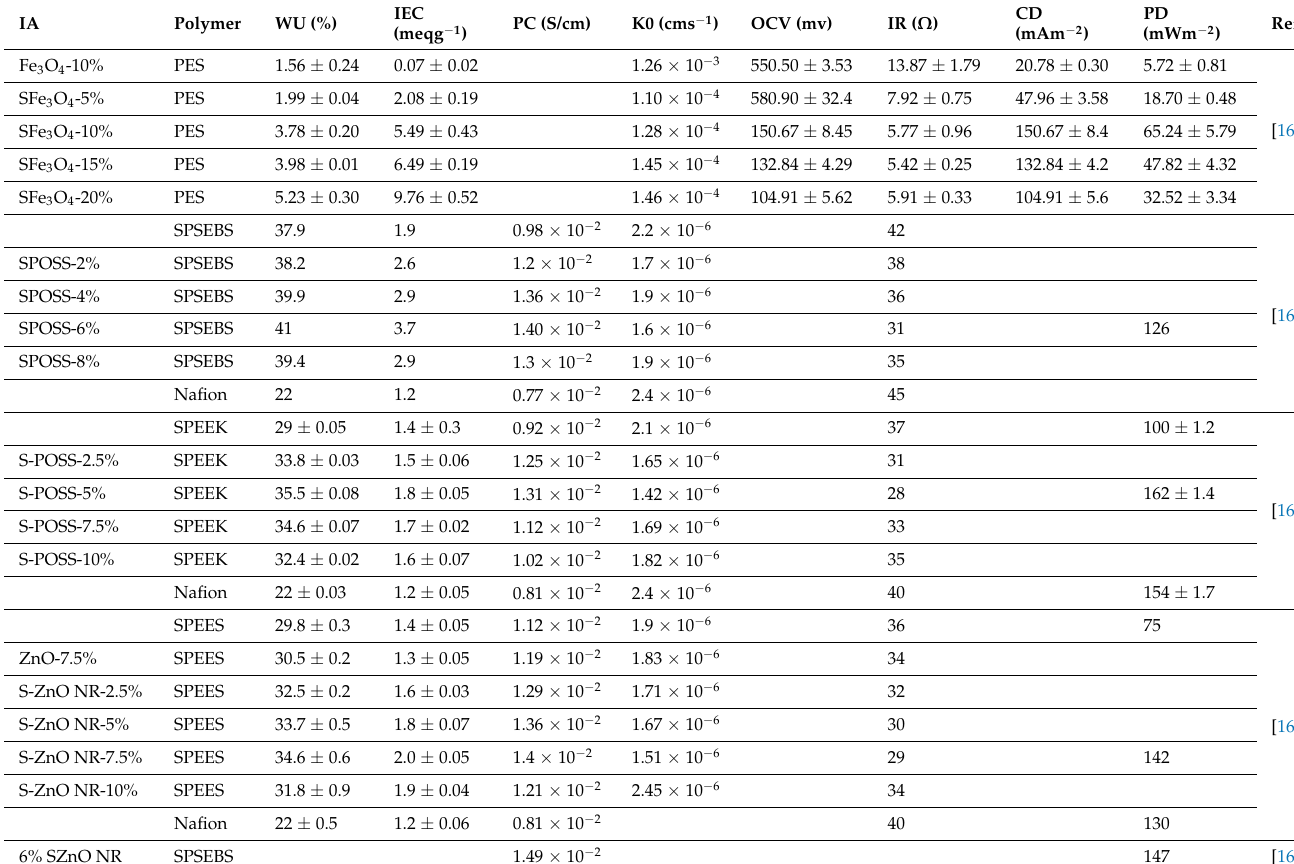
Table 4. Physicochemical properties and performance evaluation results of different kinds of sul- fonated additives containing polymer membrane for MFC